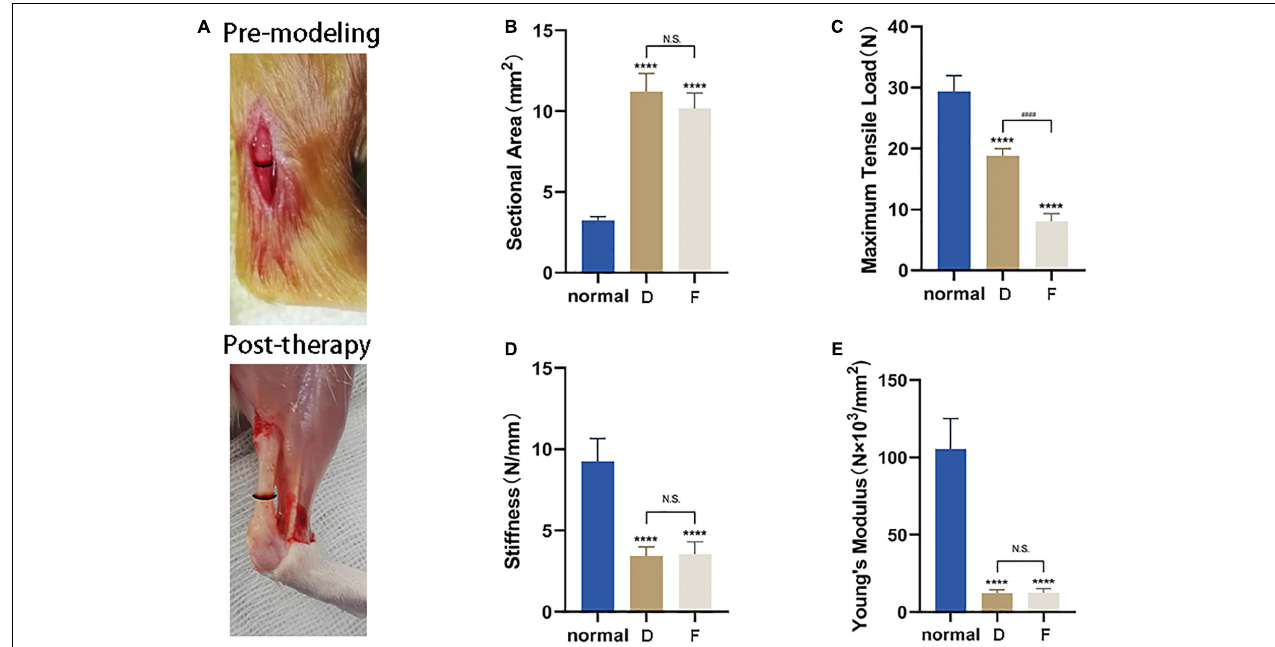
FIGURE 8 | CM enhances the biomechanical properties of injured Achilles tendon. (A) Lesion area before and after tendon repair. (B) Healed tendon from Group D and F had a cross-sectional area nearly three times that of uninjured tissue. (C) After CM treatment, functional improvement of the maximum tensile load was still lower than in normal tendon, corresponding to 60% recovery. (D) The stiffness of samples in Group D and Group F were still far less than that of normal tissues. There were no differences between the two experimental groups. (E) Recovery of Young’s modulus of samples was same as that of stiffness. *, versus normal. **** means p < 0.0001; #, D versus F, #### means p <